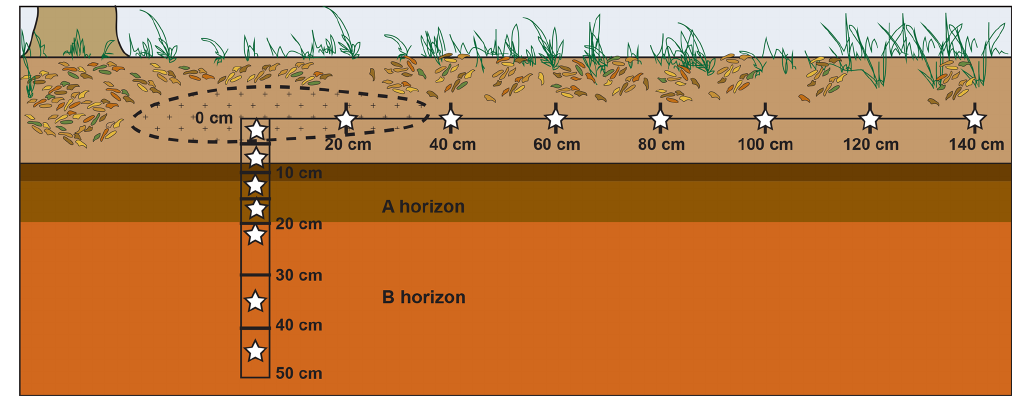
Figure 1. Schematic cross section view of the locations of soil samples (stars) collected from each of three carrion decomposition sites. Dashed line represents the hotspot – the area of visibly discolored soil. Soils collected at depth extended to the B horizon. The visibly discolored area of soil due to carrion hotspot formation extended approximately 35–40cm from the hotspot center along the surface and to a few centimeters depth.